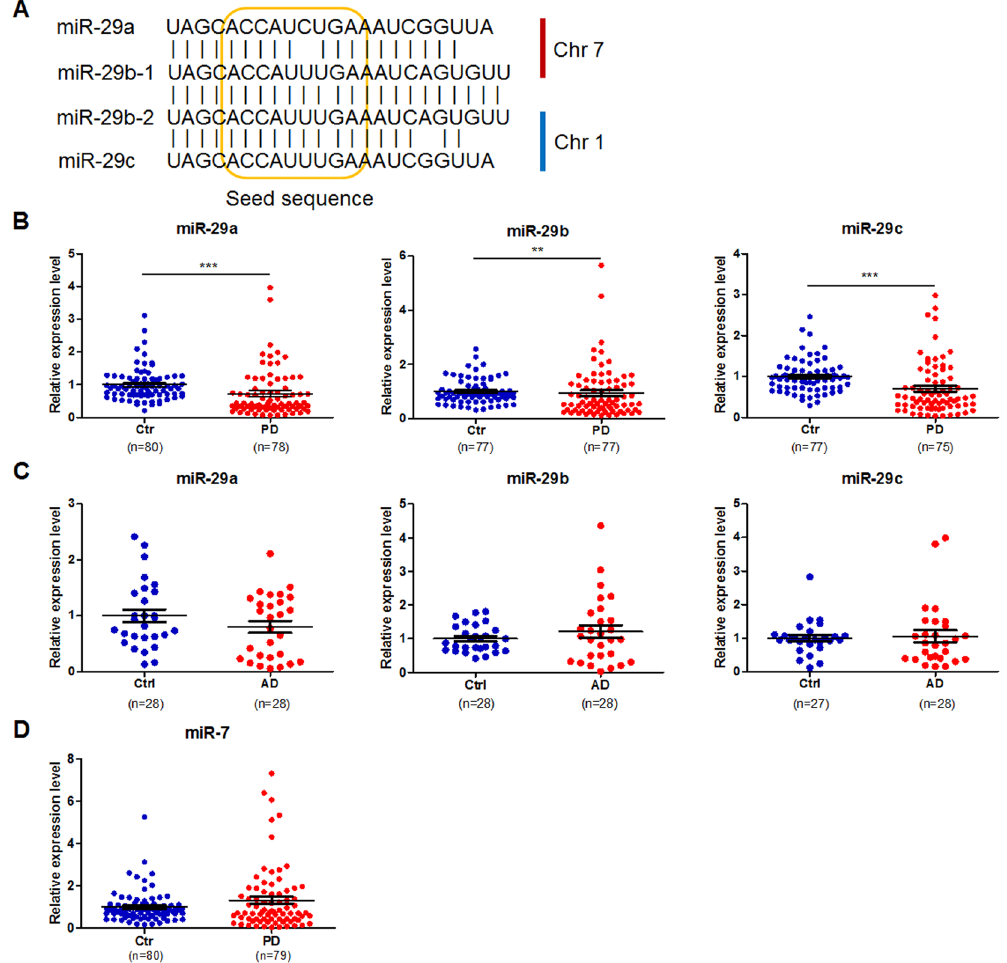
Figure 1. The alignment of human miR-29s ( A ) and the expression levels of miR-29s in the serum of control subjects and patients with PD ( B ) or AD ( C ) and the expression levels of miR-7 in the serum of controls and PD patients ( D ). Data are presented as the means ± SEM. Differences were analyzed by Mann-Whitney test. ** p < 0.01 and *** p <